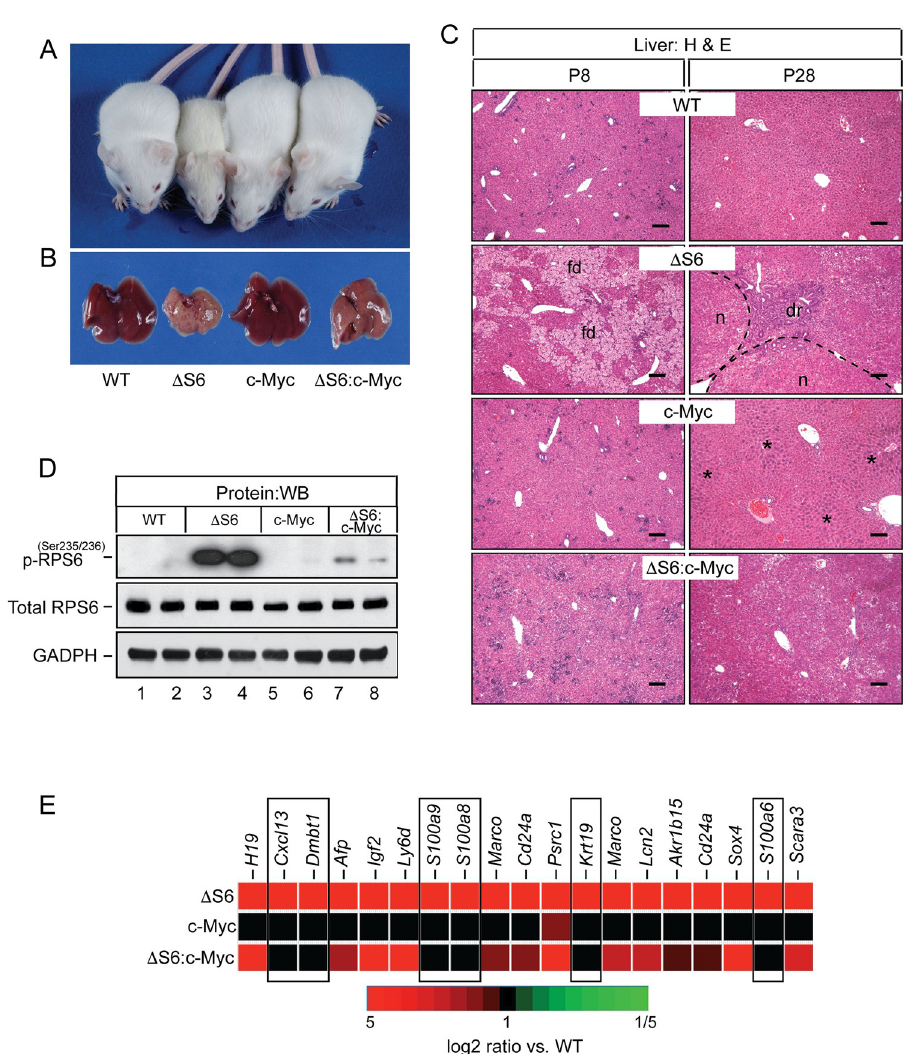
Fig 7. Overexpression of c-Myc rescues the growth defect and eliminates the requirement for Δ S6 livers to regenerate by preserving hepatocyte viability. (A) Picture of a 28 day old WT, Δ S6, c-Myc and Δ S6:c-Myc mouse. The Δ S6:c-Myc mouse (far right) is indistinguishable from the WT mouse (far left) in terms of size and lacks the jaundiced (yellowed) coat of the Δ S6 mouse (second from left). (B) Gross appearance of livers from 28 day old WT, Δ S6, c-Myc and Δ S6:c-Myc mice. Note the smooth and less jaundiced appearance of the Δ S6:c-Myc liver relative to the Δ S6 liver. (C) Photomicrographs of H&E stained liver sections of 8 and 28 day old WT, Δ S6, c-Myc and Δ S6:c-Myc mice showing the absence of feathery degeneration at P8 and lack of regenerative nodules or a dr at P28 in livers of Δ S6:c-Myc compared to Δ S6 mice. Dotted lines depict nodule boundaries. Asterisks ( � ) denote characteristic regions of hepatocyte hypertrophy in Alb-c-Myc livers (Original magnifications, x 62.5; scale bars 50 μ ). (D) Western blot showing that mTOR-dependent phosphorylation of RPS6 is suppressed by overexpression of c-Myc in Δ S6:c-Myc livers. GAPDH; protein load control. (E) Heat map showing that overexpression of c-Myc normalizes the innate immunity molecular signature comprising NF- κ B target genes and DAMPs (boxed areas), but not imprinted genes, in Δ S6